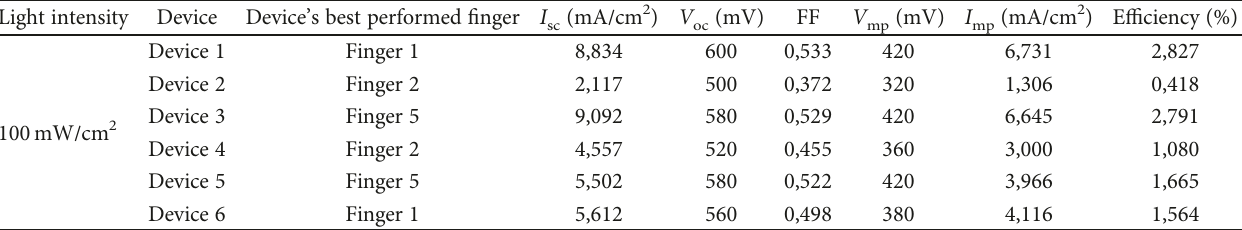
Table 1: All manufactured devices and their fi ngers with the highest e ffi ciency.